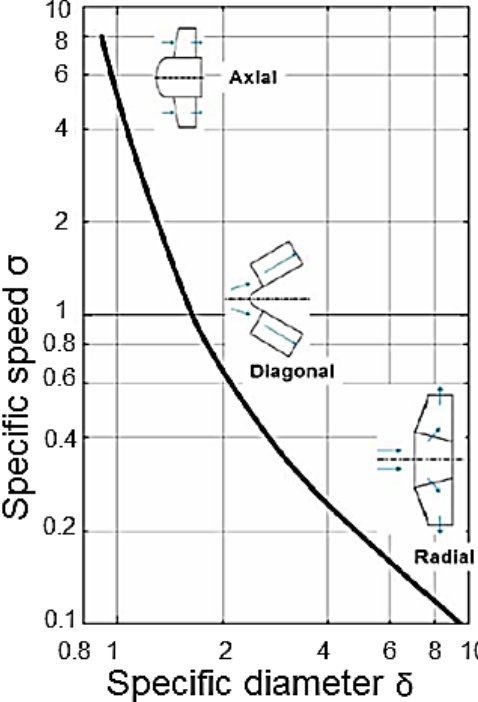
Figure 9. Cordier diagram showing specific speed vs. specific diameter—image courtesy of [17].